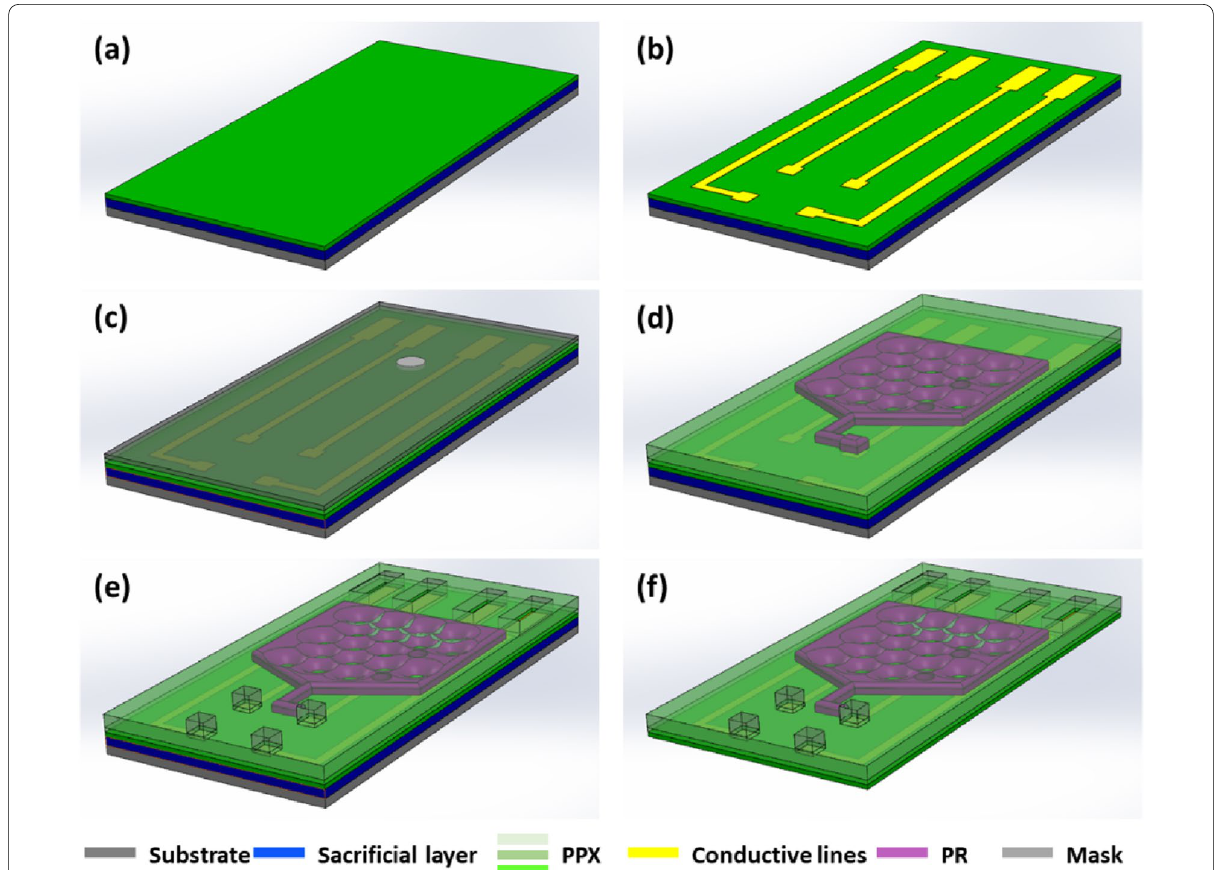
Fig. 2 Fabrication processes of a parylene‑C‑based μFIC. a – f MEMS techniques including sputtering, photolithography, deposition, and dry etching were used for